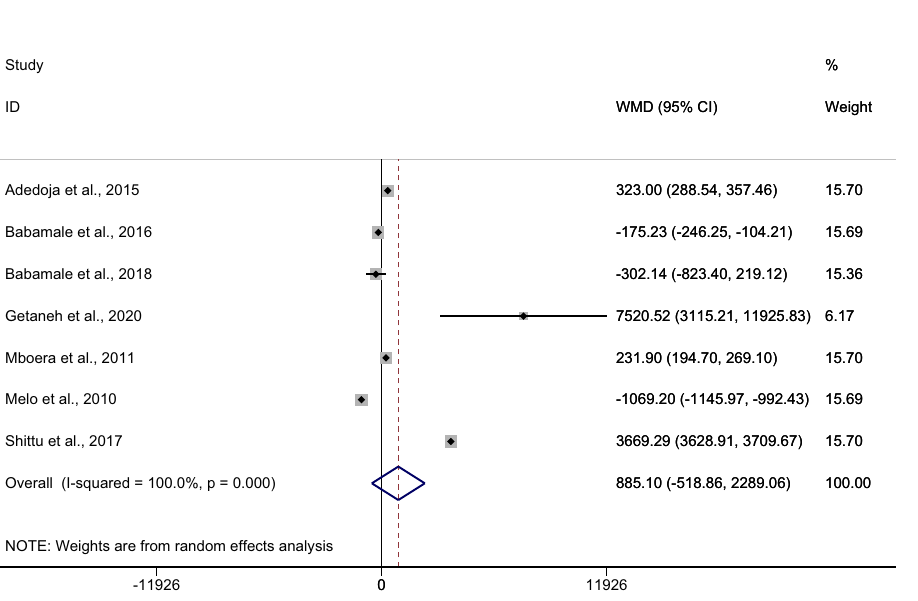
Figure 5. Mean malaria parasite density between patients with Plasmodium spp. and hookworm co-infection and Plasmodium mono-infection. WMD weighted mean difference, CI confidence